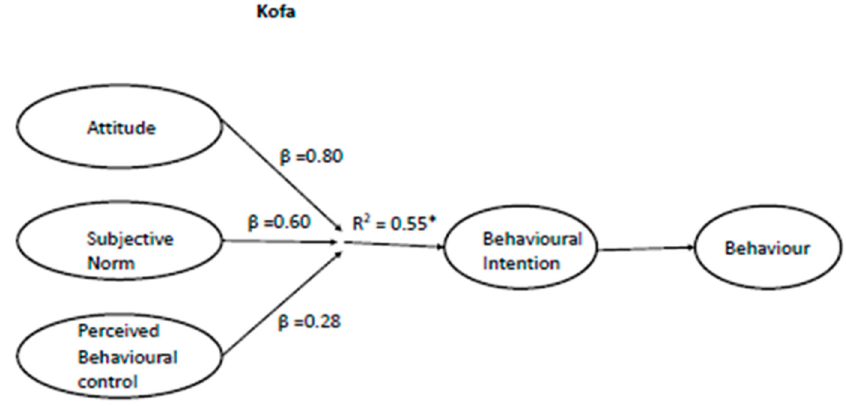
Figure 9. Theory of planned behaviour model for climate change adaptation determinants for the Kofa community (* p < 0.05).